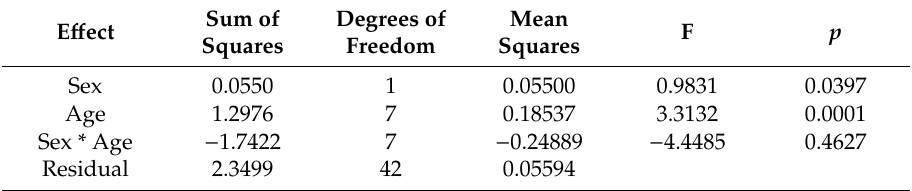
Figure 2. Coefficients (loadings) of the morphometric variables for first principal component, which explained 85.47% of the variability in individuals of both sexes of Araucan pig ( n = 58). As all loadings were positive, they can be interpreted as a generalized body size. Thoracic circumference (PT), body length (LCO), withers height (ALC), sternum height (ALES), head length (LCA) and width (ACA), ear length (LORE) and width (AORE), hindlimb cannon perimeter (PCAP), knee circumference (PRO), and hock height (ACO). Table 1. ANCOVA of the scores for male ( n = 31) and female ( n = 27) individuals and age of Araucan pigs, using the generalized body size (first axis of the principal component analysis, PC1) as a covariate.